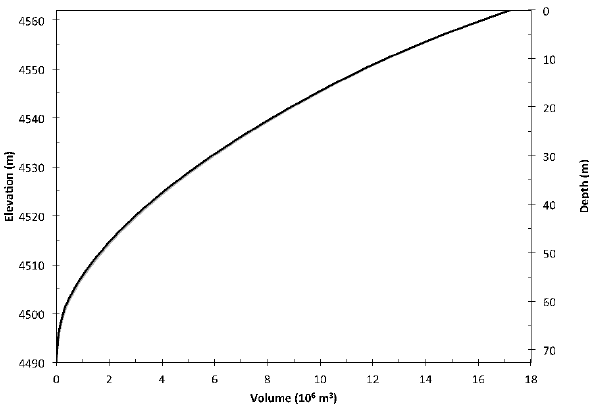
Figure 7. Volume–elevation–depth curves for Lake